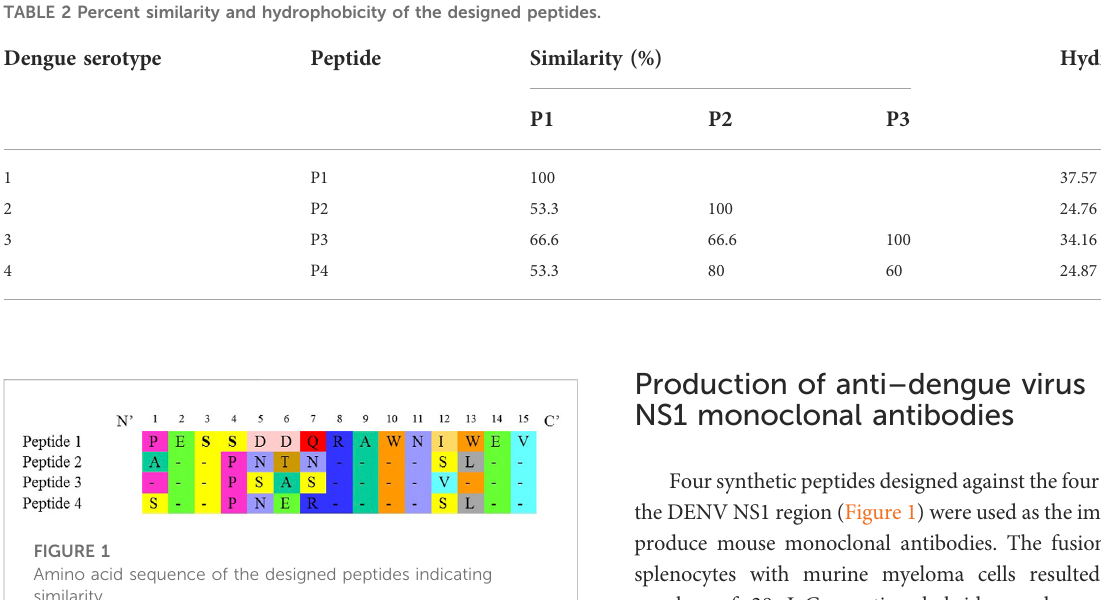
FIGURE 1 Amino acid sequence of the designed peptides indicating